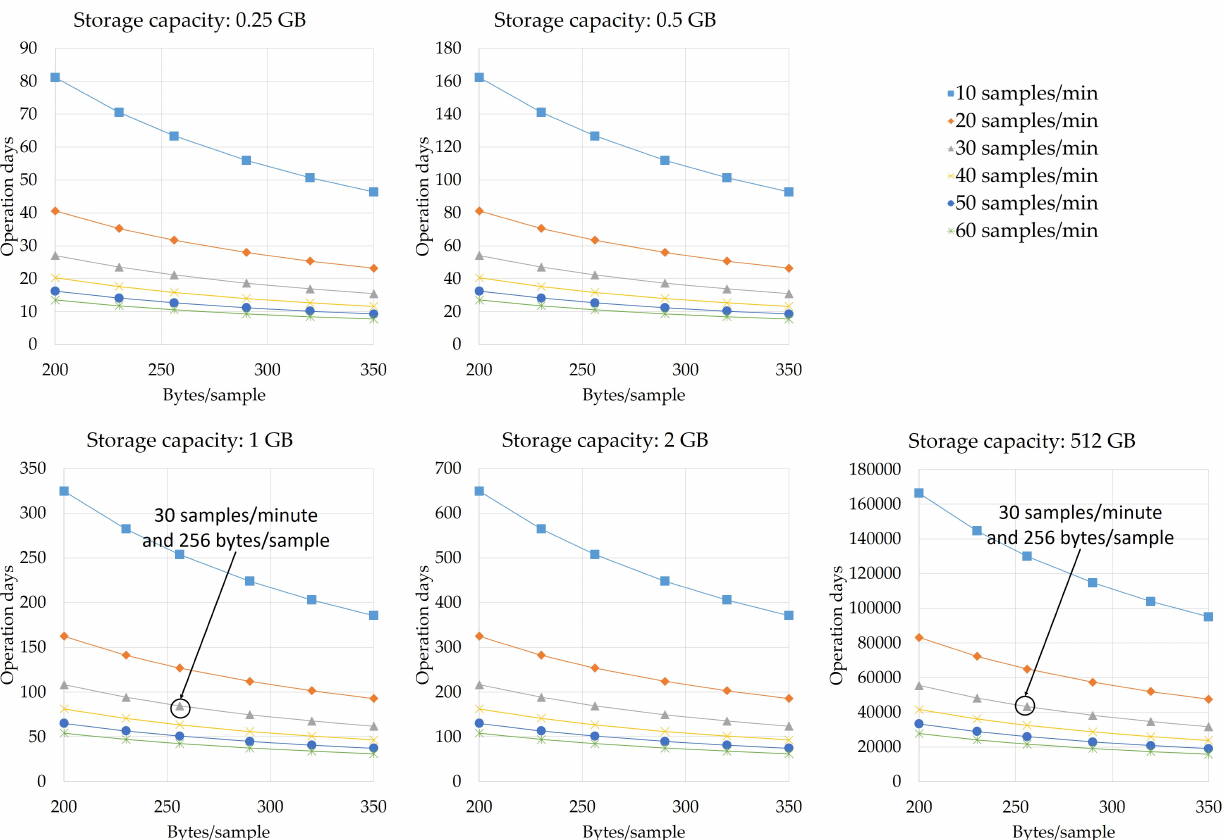
Figure 17. Maximum storage period for different capacities that can be achieved in NAND flash memory units. For a storage capacity of 1 GB, 30 samples per minute, and length of 256 bytes per sample, it is possible to achieve a storage time of 84 days. In case a storage was done on a larger capacity NAND flash memory like 512 GB, then it could be stored for more than 40,000